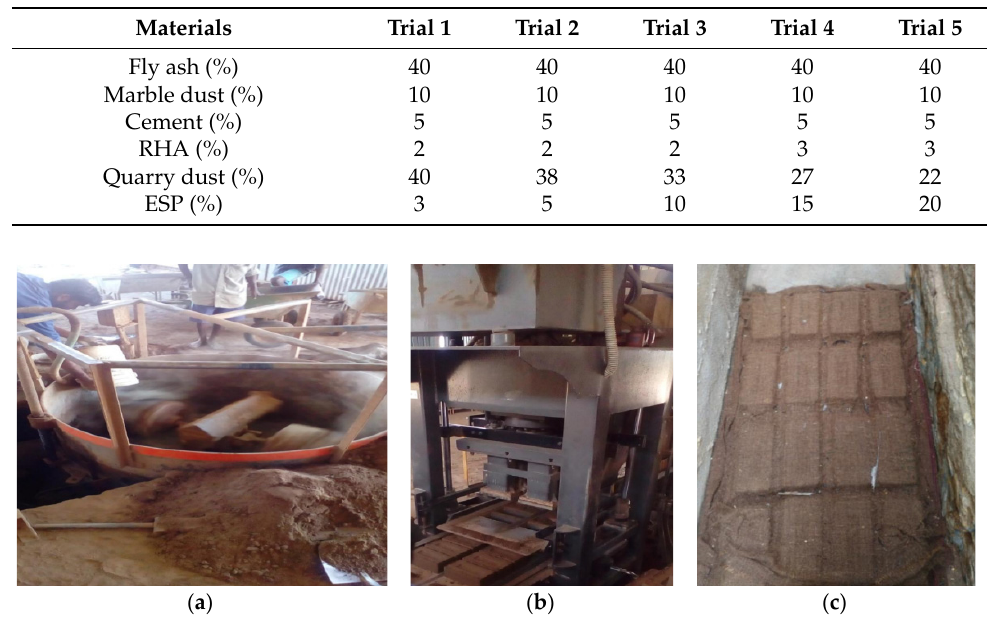
Figure 2. Specimen preparation process: ( a ) mixing of materials, ( b ) casting of bricks, and ( c ) curing of bricks.